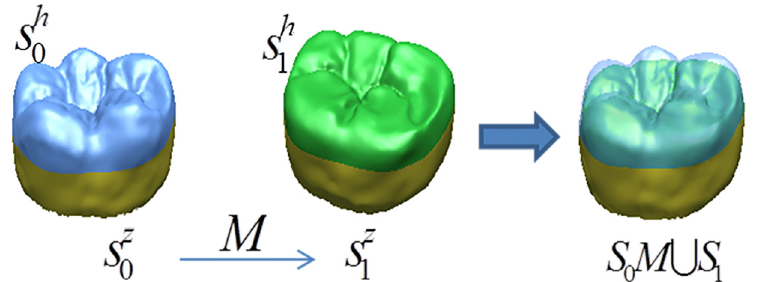
Fig 3. Feature alignment before and after attrition. The yellow area is a selective alignment area, the blue area is occlusal surface S h 0 before attrition and the green area is occlusal surface S h 1 after